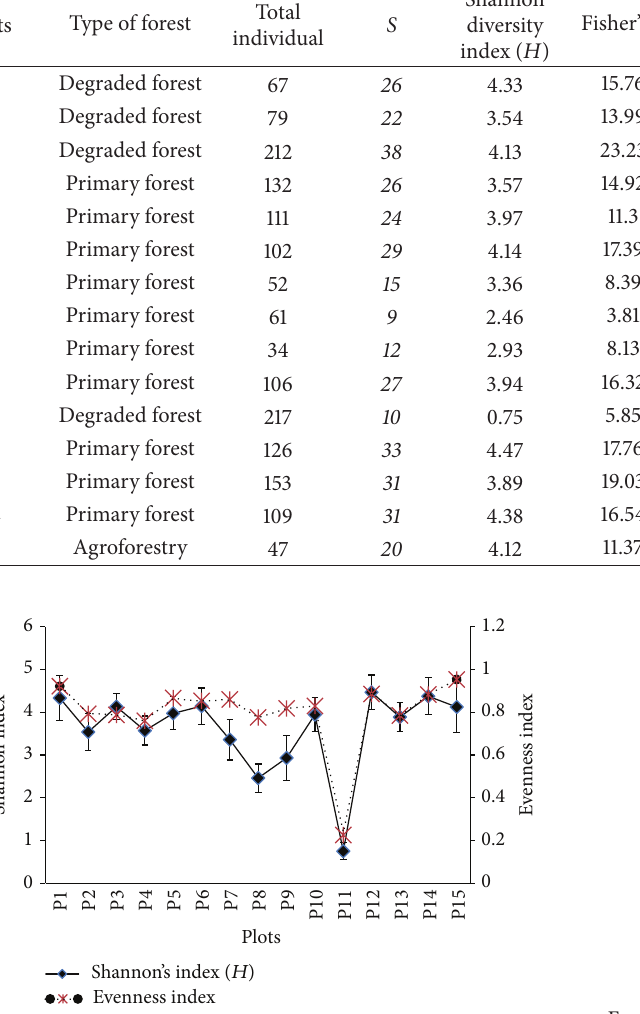
Figure 4: Shannon diversity index and evenness index trends in all the study areas.